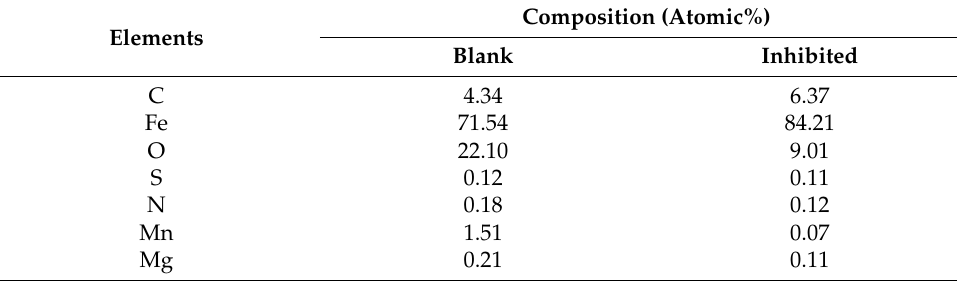
Figure 6. EDX spectra of mild steel dipped in: ( a ) 1 M HCl; ( b ) 1 M HCl with 600 ppm of inhibitor. Table 4. Percentage compositions of elements present on the mild steel